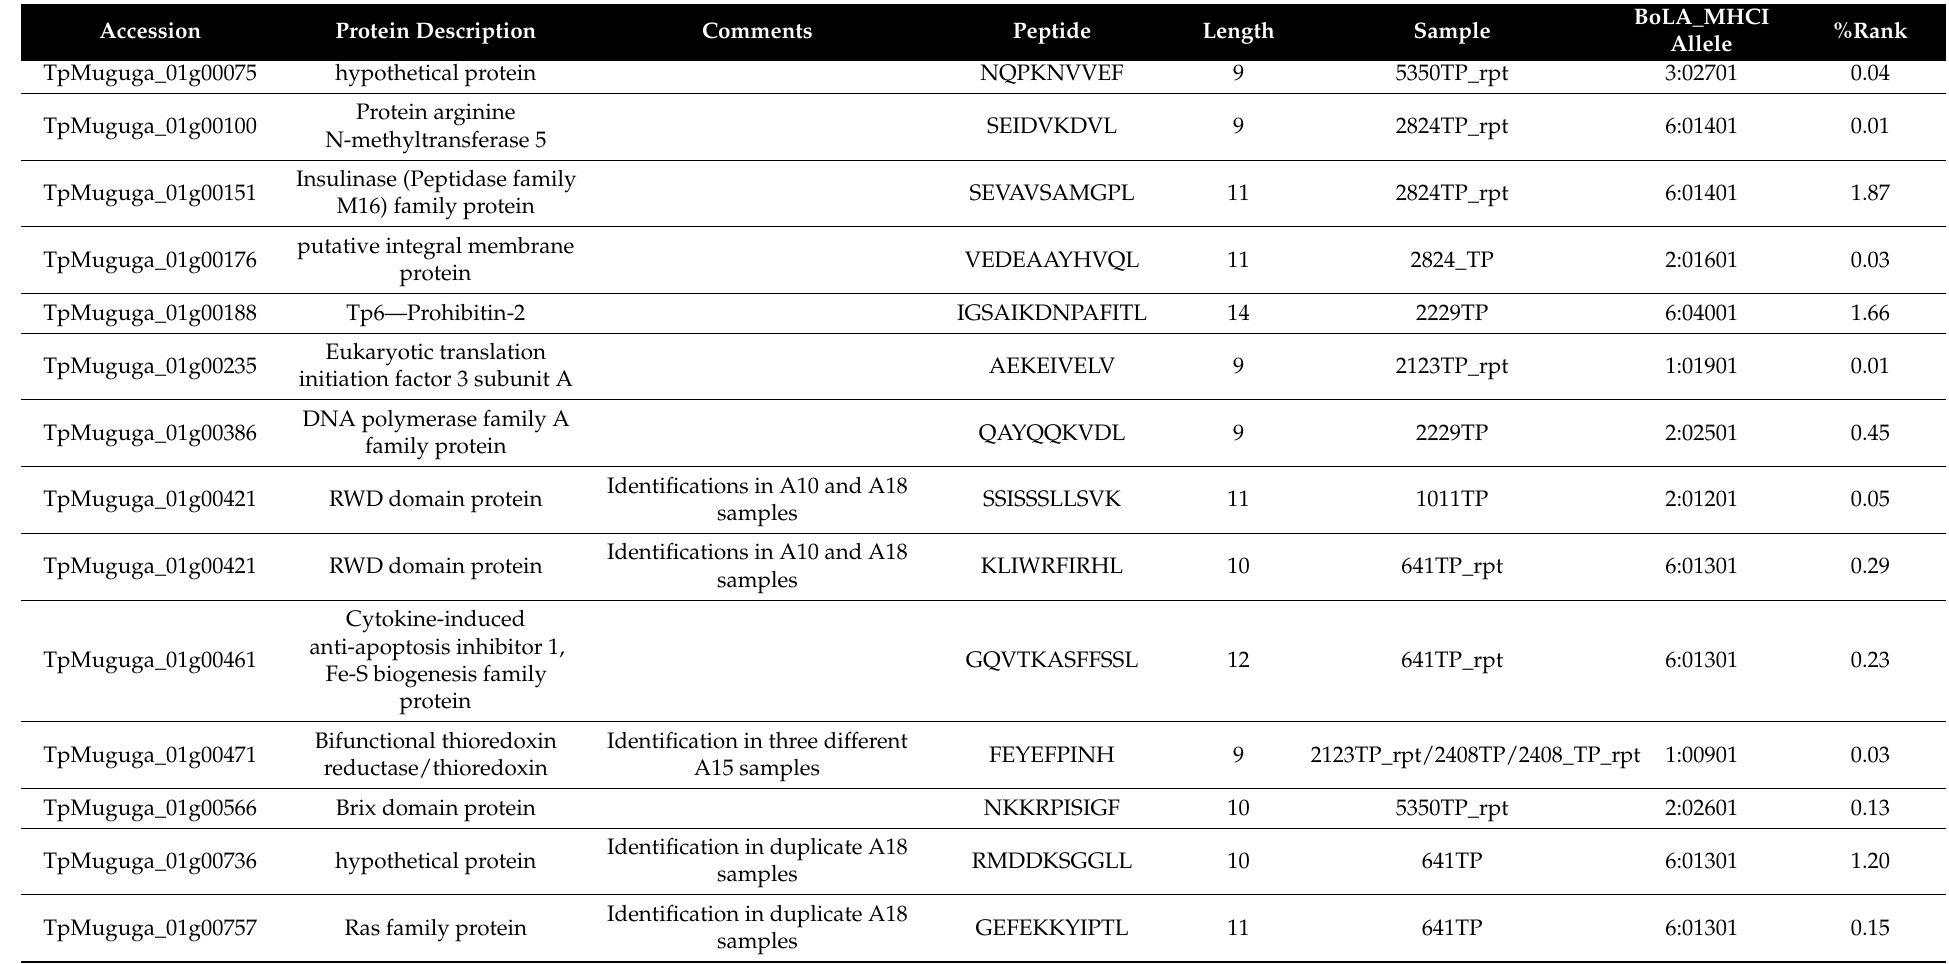
Table 3. Predicted BoLA-I presented T. parva peptides identified in this study. For each peptide, the accession number and description of the protein from which it is derived are shown in columns A and B, and specific comments about particular proteins are given in column C. Columns D–H provide details about the individual peptides, including their sequence, length, the sample(s) they were identified in, the BoLA-MHCI allele predicted to present the peptide, and the predicted percent rank binding